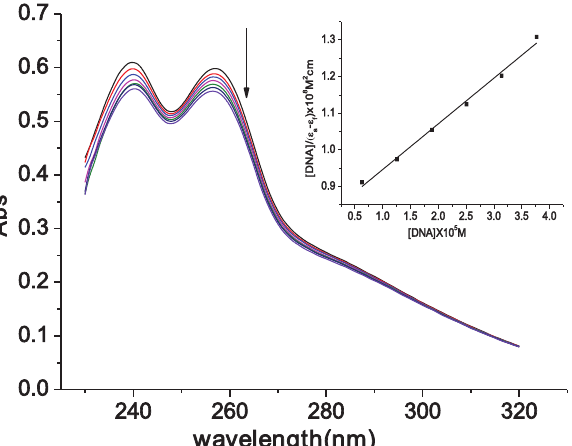
Figure 4: Emission spectra of the HS-DNA–EB system upon titration of the complex. Arrow shows the change upon increasing complex concentration. Inset: I /I vs. 0